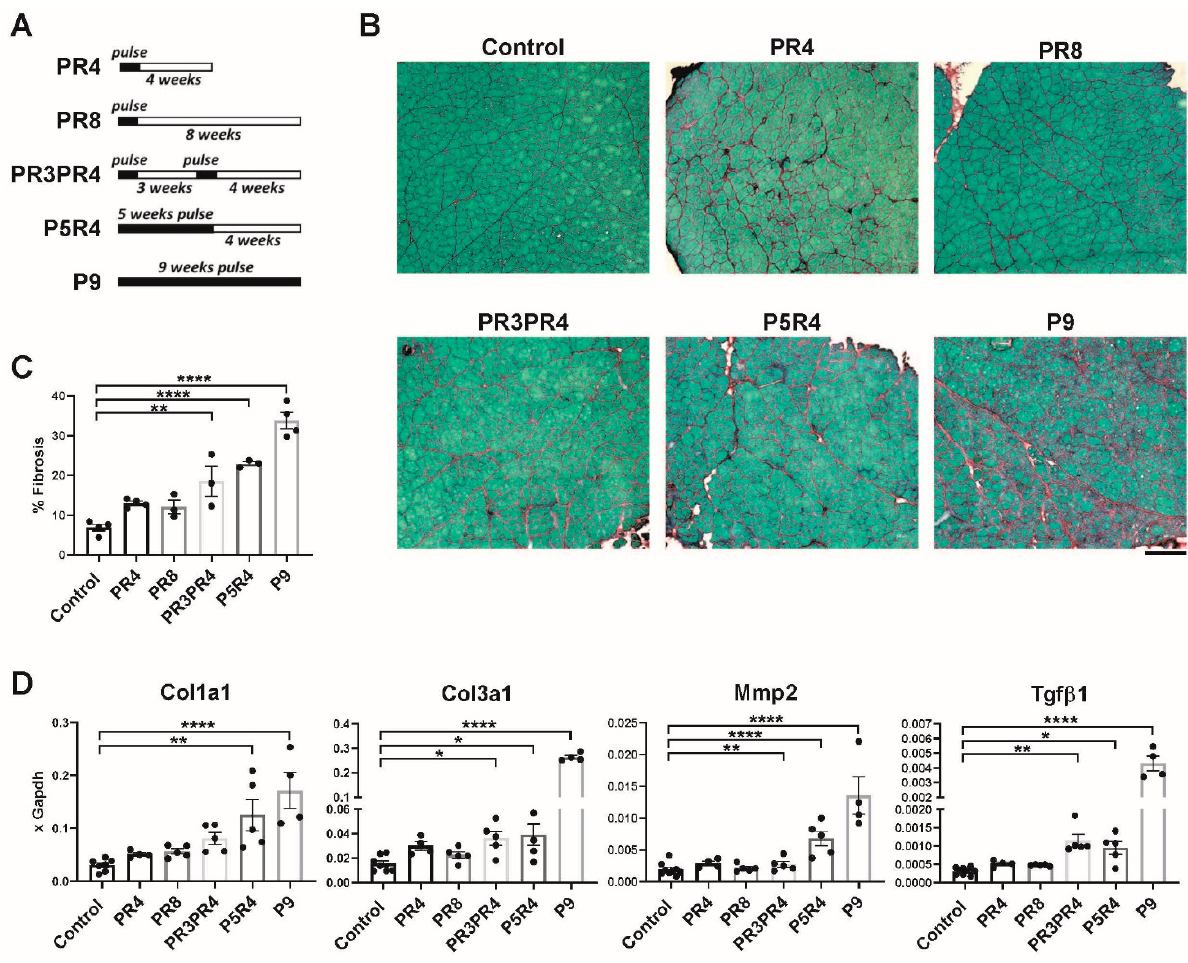
Figure 3. ( A ) Scheme of doxycycline pulse induction protocol in iDUX4pA;HSA mice. Mice received either a 10 day pulse, two such pulses, or a 5 week pulse. Muscles were analyzed histologically at the end of the indicated period. A continually induced control is indicated as a ‘9 weeks pulse’. ( B ) Representative Sirius Red/Fast Green images of TA muscle of iDUX4;HSA mice exposed to the different pulses of DUX4 shown in ( A ). Scale bar 100 µ m. ( C ) Quantification of deposition of fibrous tissue in the muscle represented in ( C ). ( D ). RT-qPCR for genes related to fibrosis in gastrocnemius from mice exposed to the different pulses of DUX4 shown in ( A ). Data represent mean ± SEM; * p < 0.05 ** p < 0.01, **** p < 0.0001, by one-way ANOVA.